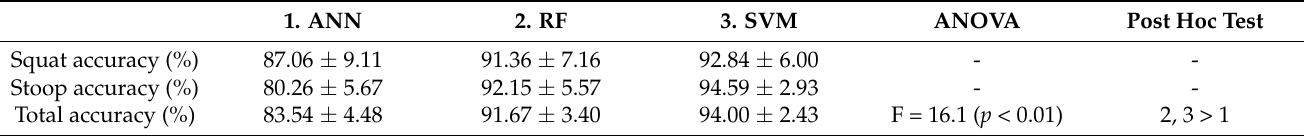
Table 4. Symmetric lifting task posture classification accuracy for three classification